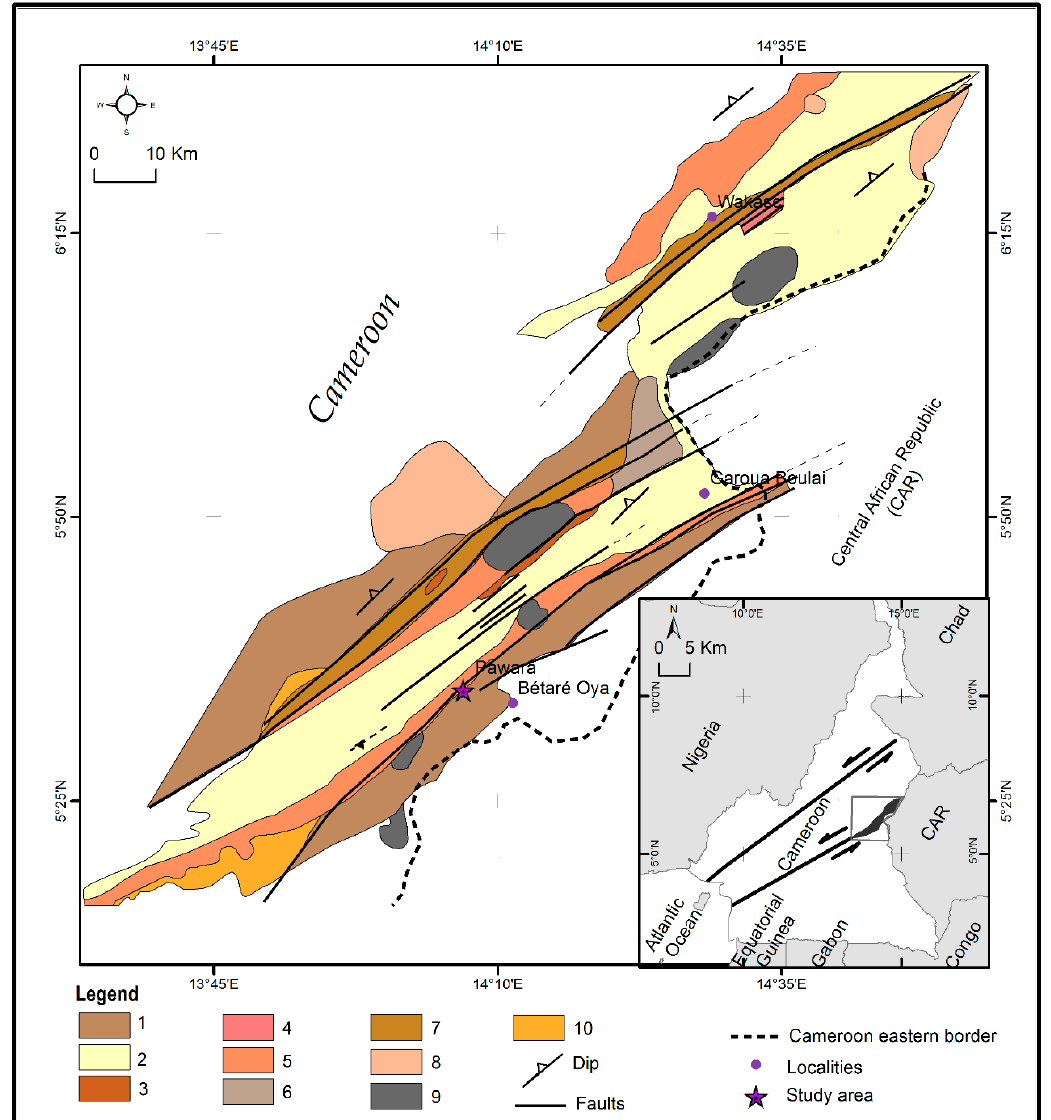
Figure 1. Geological sketch of the Lom series presenting the study area and the monocyclic unit associated with the grabbens (modified from [24]). (1) Orthogneiss; (2) Lom volcaniclastic series; (3) polygenic conglomerates; (4) Mari quartzites; (5) staurolite micashists; (6) sillimanite gneiss from the Lom bridge; (7) chloritoid and staurolite mylonites. Intrusions with an uncertain structural relationship; (8) granites; (9) granites and monzonites; (10) metalamprophyres.